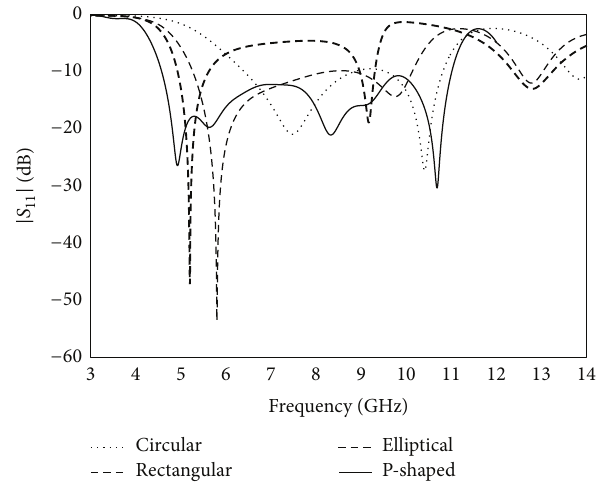
Figure 7: Simulated reflection coefficient for different slot shapes.